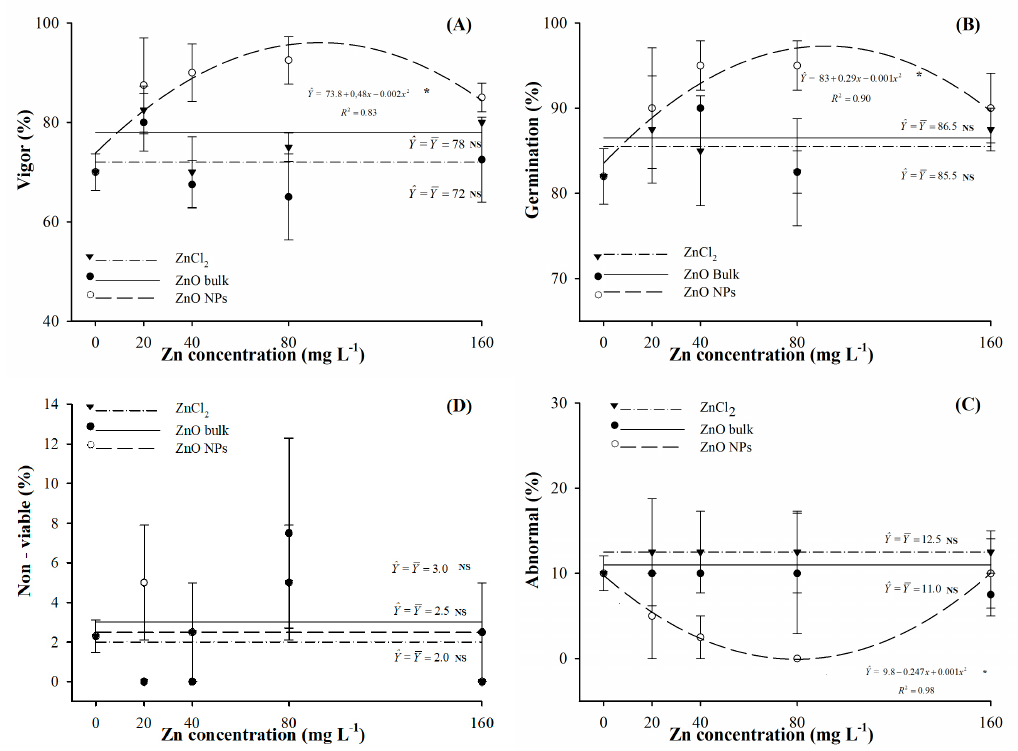
Figure 3. Seed vigor ( A ), seed germination ( B ), non-viable seed ( C ), and abnormal seed ( D ) of corn after application of different concentrations and sources of Zn. * = significant at 5% of probability by regression test. NS = non-significant at 5% of probability by regression test.